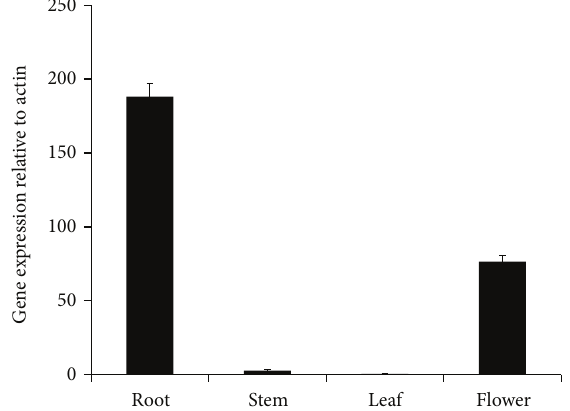
Figure 4: Transcript levels of SbFLS in different organs. The height of each bar and error bars represent means and standard errors, respectively, from 3 independent measurements.